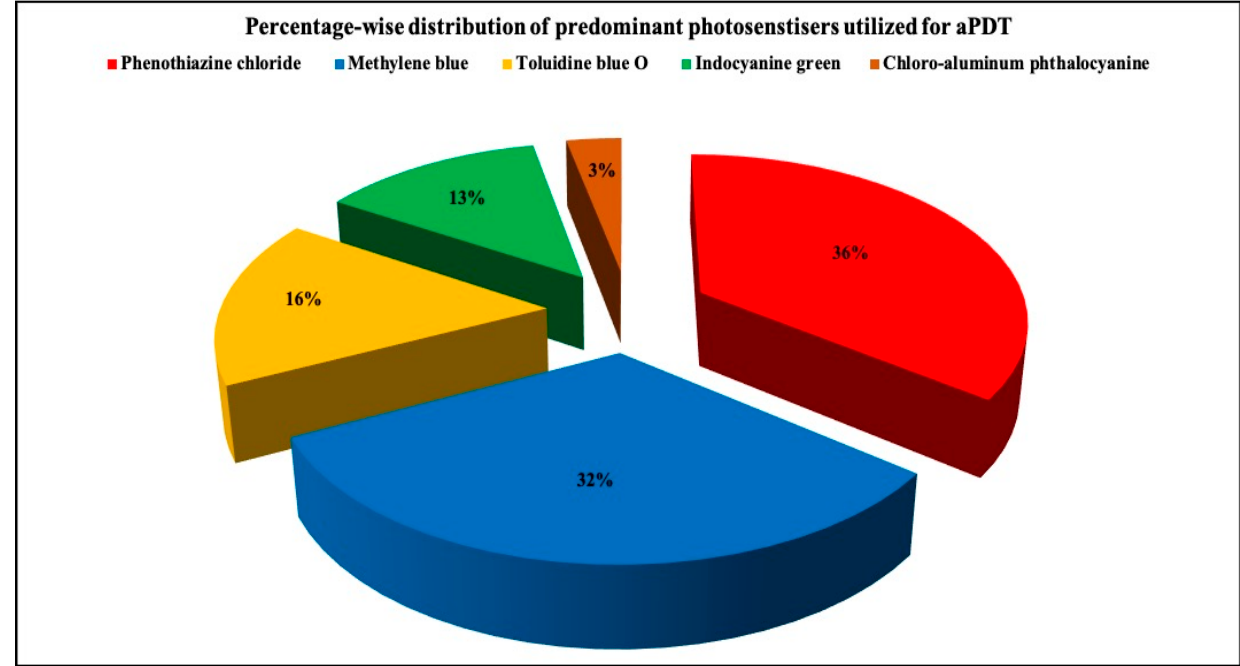
Figure 3. 3D pie diagram illustrating the percentage-wise distribution of predominant photosensitizers utilized for aPDT in the included studies.